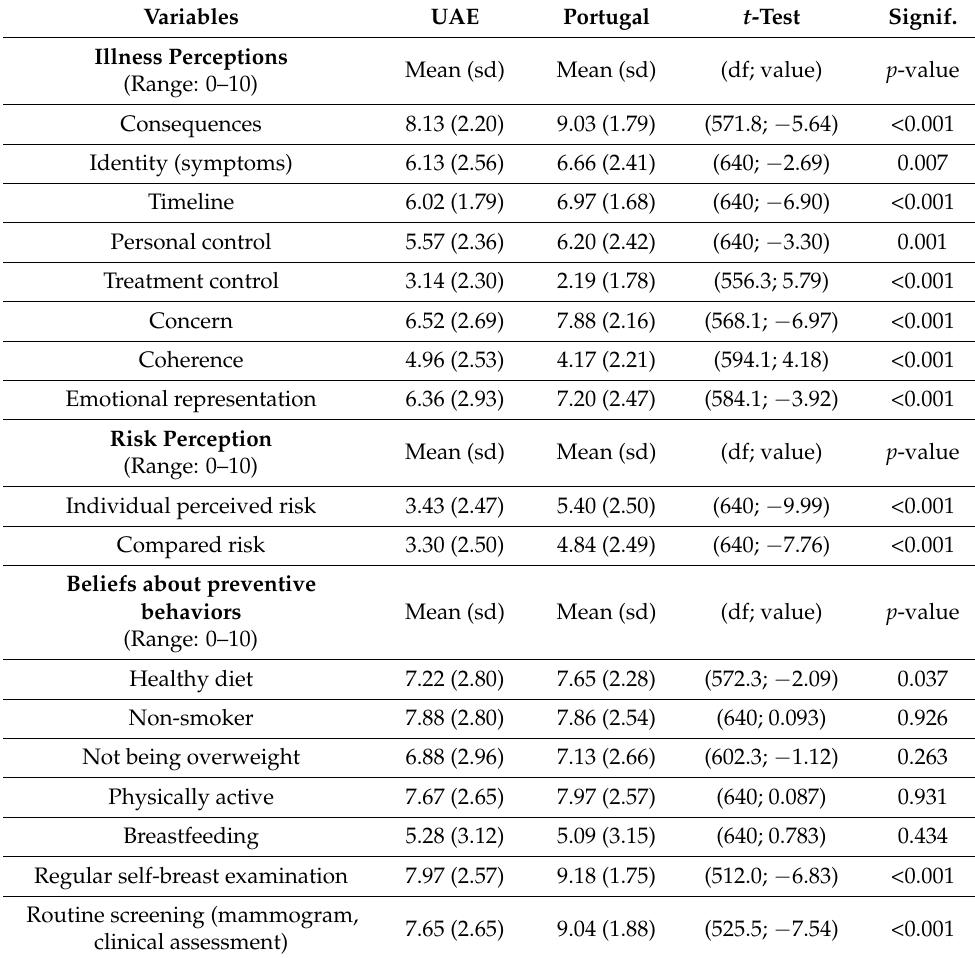
Table 1. Comparison between countries on the study